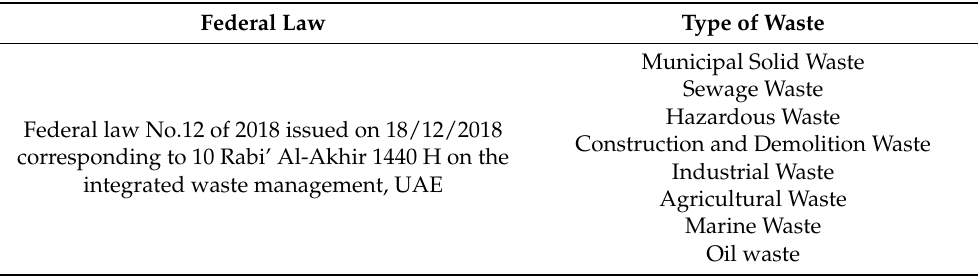
Federal law No.12 of 2018 issued on 18/12/2018 corresponding to 10 Rabi’ Al-Akhir 1440 H on